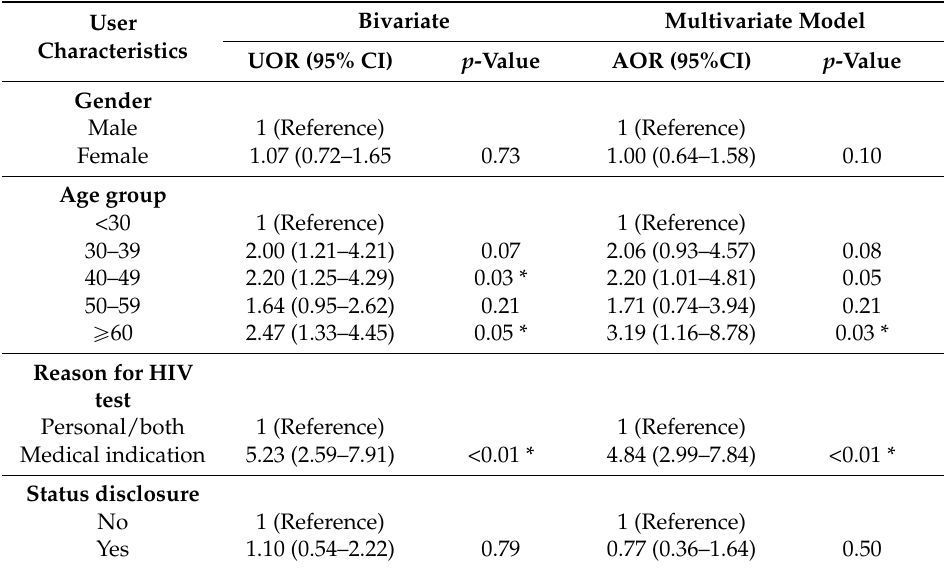
Table 3. Multivariate results (unadjusted and adjusted Odds Ratio) for variables associated with